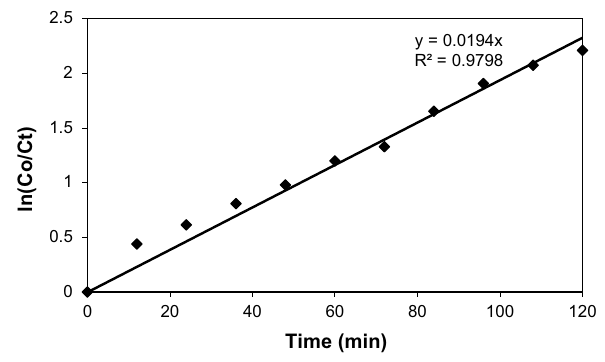
Fig. 2 Photocatalytic tests with TiO flow rate = 4 mL s −1 , T = 25 °C)